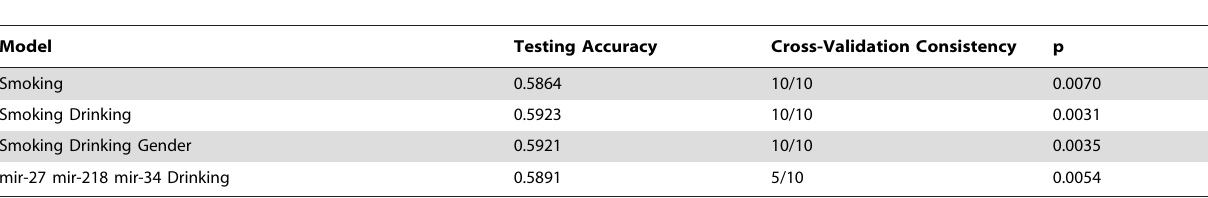
Table 6. MDR analysis for the ESCC risk in genetic and non-genetic